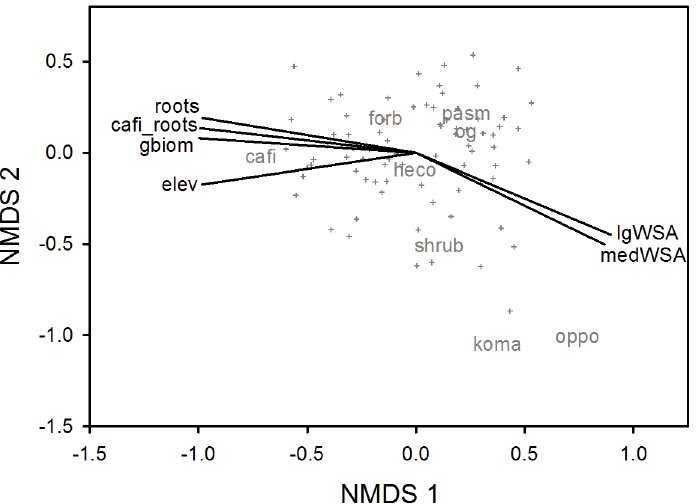
Fig 4. Non-metric multidimensional scaling (NMDS) graph of vegetation sample dissimilarities with best correlating environmental variables plotted as vectors. Sample (i.e. field plot) symbols are crosshairs. Major plant category (e.g. species, functional group) abbreviations in gray include: cafi, Carex filifolia ; forb, forbs; heco, Hesperostipa comata ; koma, Koeleria macrantha ; og, other grasses; oppo, Opuntia polyacantha ; pasm, Pascopyrum smithii ; and shrub, Artemisia shrubs. Abbreviations for environmental vectors are as follows: cafi_roots, Carex filifolia roots (0 – 10 cm); elev, elevation gain from lowest sampled point; gbiom, dominant graminoid (aboveground) biomass; lgWSA, % water-stable aggregates (2 – 4 mm